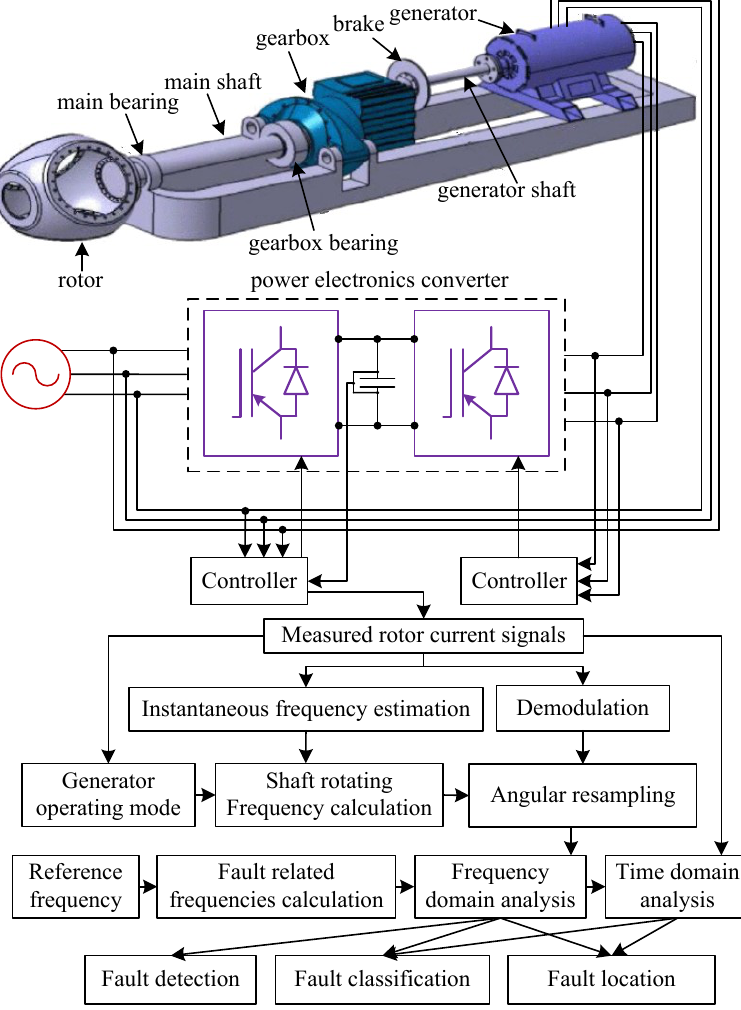
Figure 10. Gearbox fault diagnosis